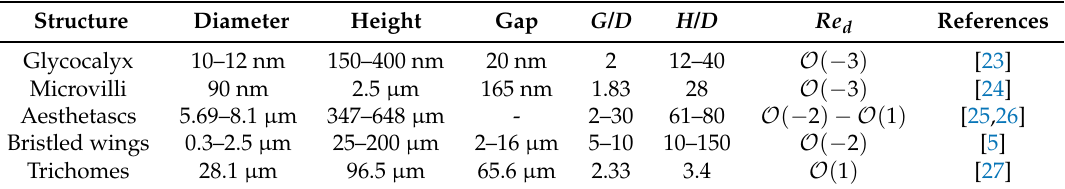
Measured morphological parameters of various cylinder-like structures in biology. The diameter based Reynolds Number, Re d , was computed using the length scale as the diameter of the cylinders, kinematic viscosity of air or water. The characteristic velocity was chosen as the free stream velocity (approximately 1–2 m/s for trichomes, the wind speed on an average day). Trichome measurements were taken from images using